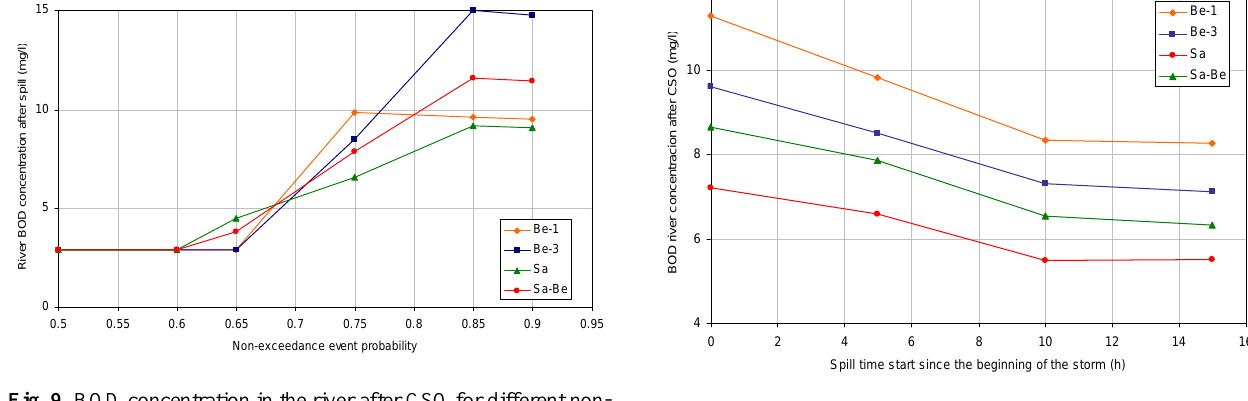
Fig. 10. BOD concentration in the river after CSO for non- exceedance storm probability P